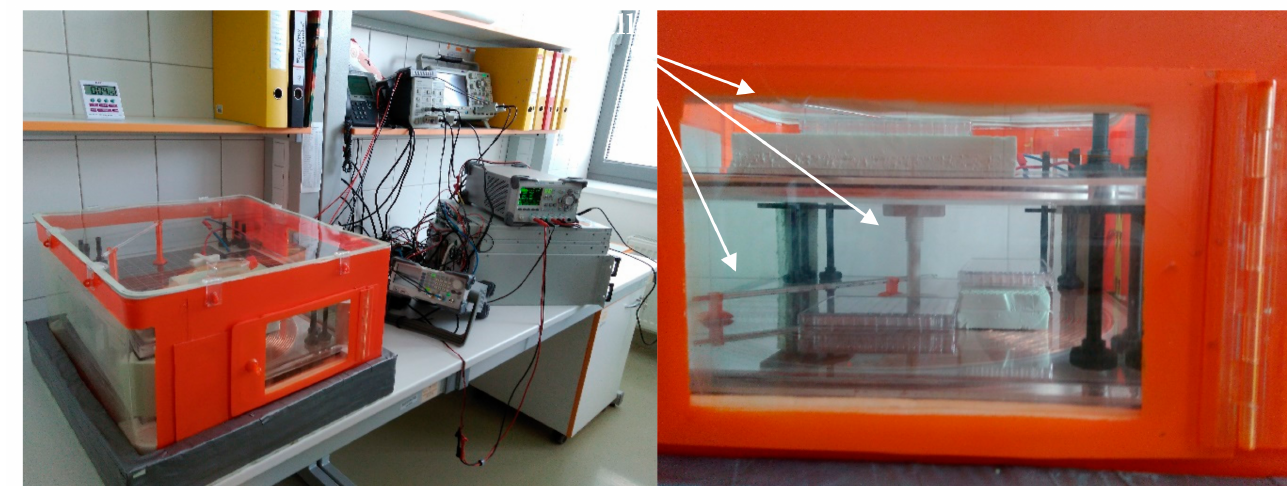
Figure 9. Experimental set-up of the wireless power transfer system ( left ) and detail of location of biological samples within the coils coupling system ( right